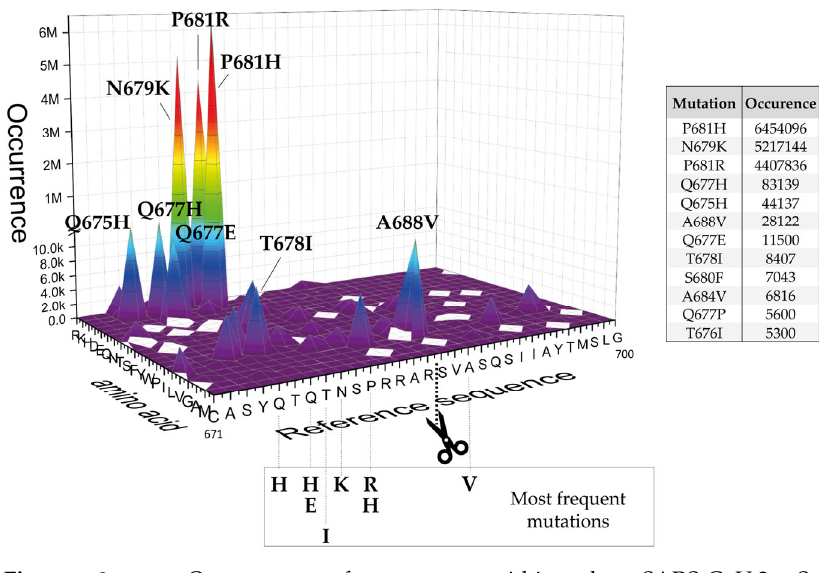
Figure 2. Occurrence of mutants within the SARS-CoV-2 S cleavage site 671 CASYQTQTNSPRRARSVASQSIIAYTMSL 700 (GISAID sequence database). Overall, we found that residues at P positions vary much more than those at P’ positions, in line with the evidence that the Furin catalytic site preferentially recognizes stretches before the scissile bond rather than after. Thus, the refinement of the trait